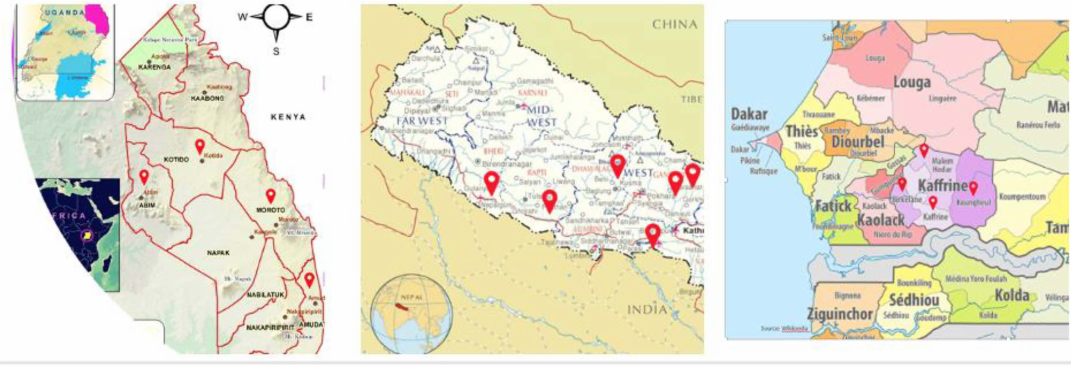
Figure 1. Study sites in Uganda, Nepal and